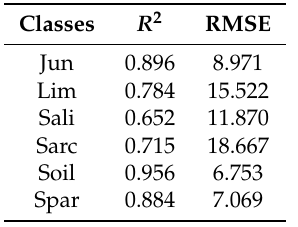
Table 3. Accuracy information for RF soft classification. Jun = Juncus , Lim = Limonium , Sali = Salicornia ,